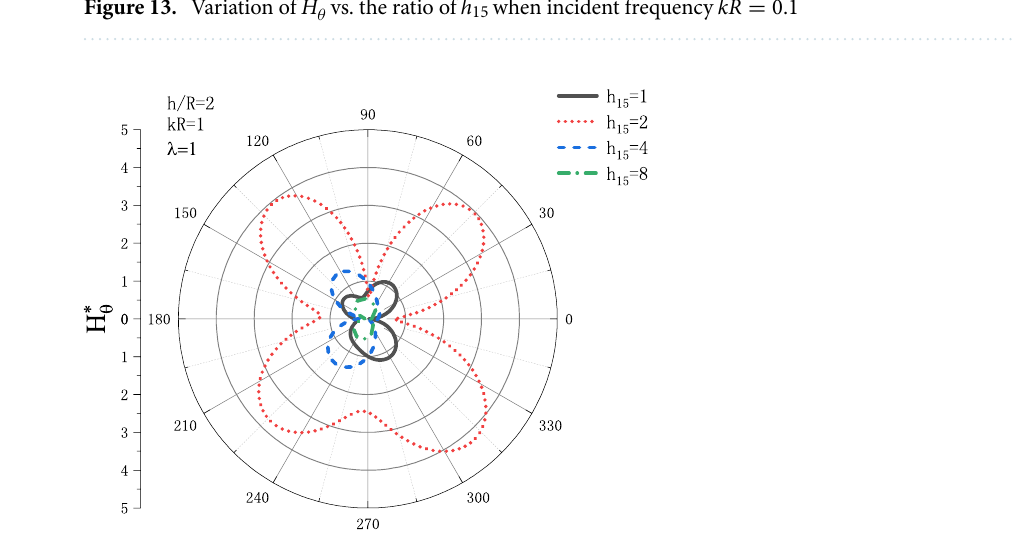
Figure 14. Variation of H